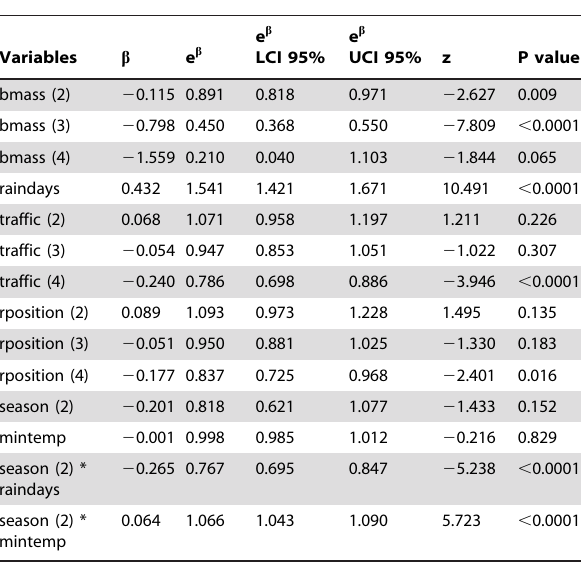
Table 2. Multivariate Cox hazards models for the persistence time of ‘‘all taxa ’’ data set, stratified by taxonomic group ( b : coefficients, e b : hazards ratio, e b LCI 95%: 95% lower confidence interval for hazards ratio, e b UCI 95%: 95% upper confidence interval for hazards ratio, z: Wald test, P value: significance of Wald test); performance parameters of the model: R 2 = 0.099; Likelihood test=464.9, df=14, P-value , 0.0001.